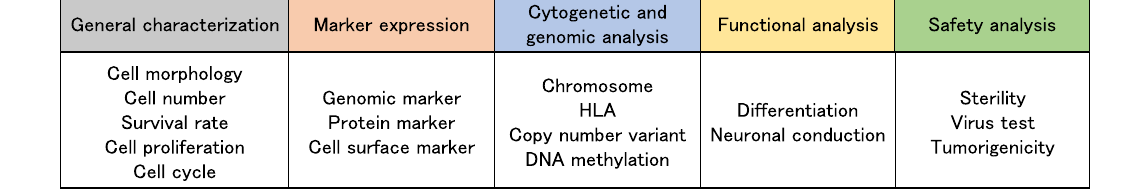
Fig. 1 Flow of iPSC-NPC transplantation toward a first-in-man clinical